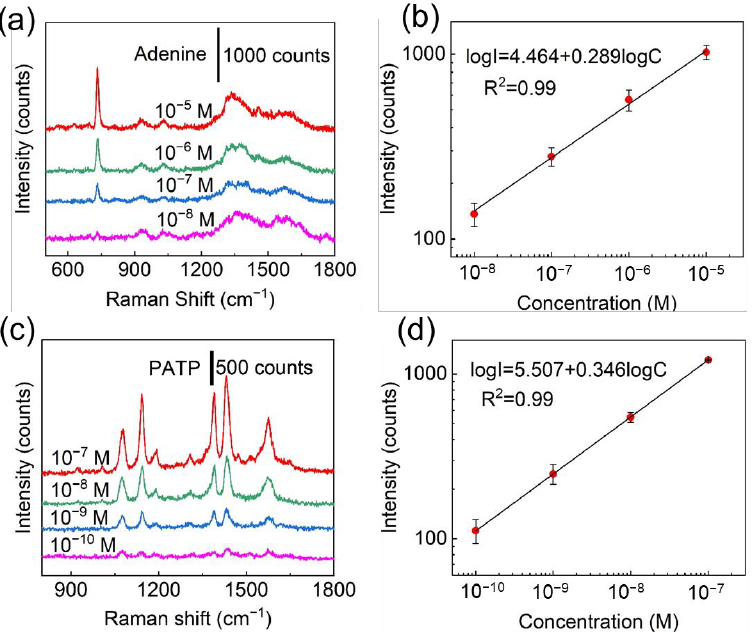
Figure 3. ( a ) Raman spectra of adenine at concentrations from 10 − 5 M to 10 − 8 M. ( b ) Linear relation- ship between logarithmic concentrations of adenine and logarithmic SERS intensities of 733 cm − 1 peak. ( c ) SERS spectra of PATP at concentrations ranging from 10 − 7 M to 10 − 10 M. ( d ) Linear relationship between logarithmic intensities at 1435 cm − 1 and logarithmic concentration of PATP.